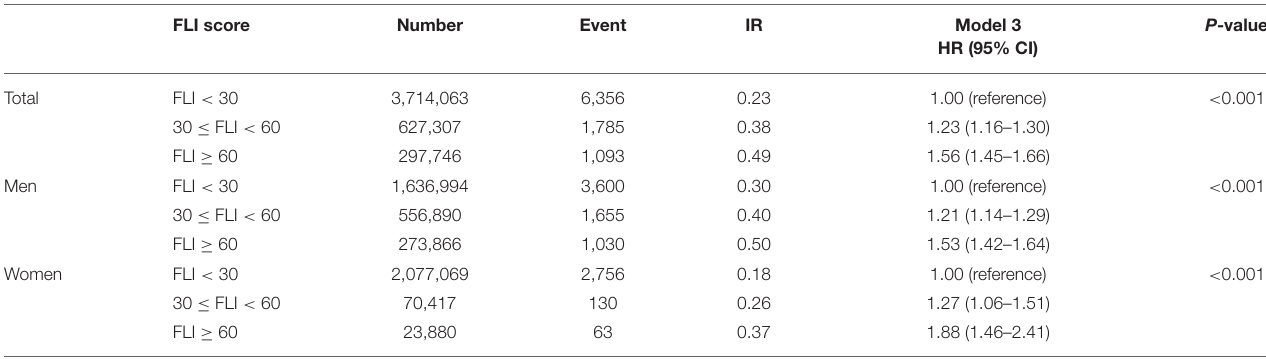
TABLE 2 | Sensitivity analyses: analyses on subjects without significant cardiovascular comorbidities including hypertension, diabetes mellitus, dyslipidaemia, heart failure, prior ischemic stroke, and prior myocardial